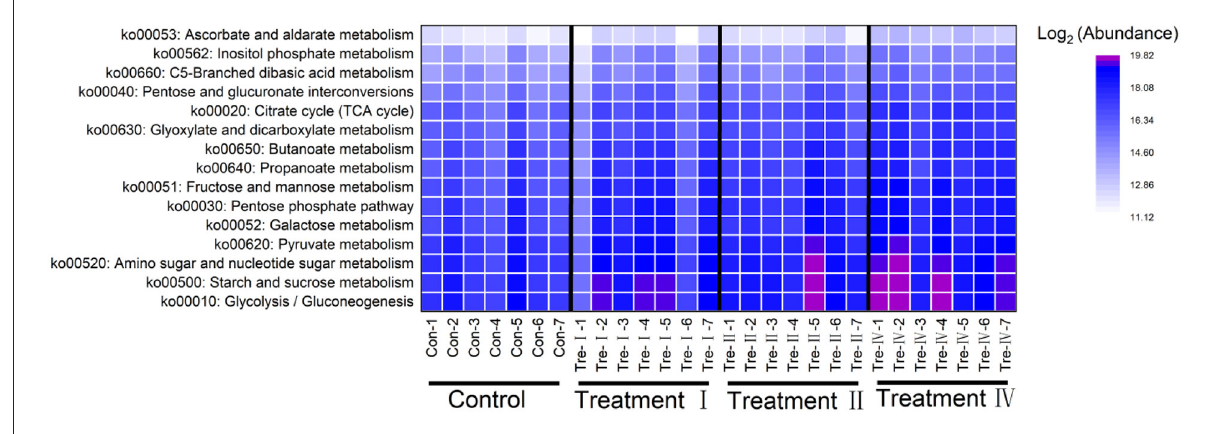
FIGURE6 Distribution of carbohydrate metabolism related pathways of fecal microbiota.